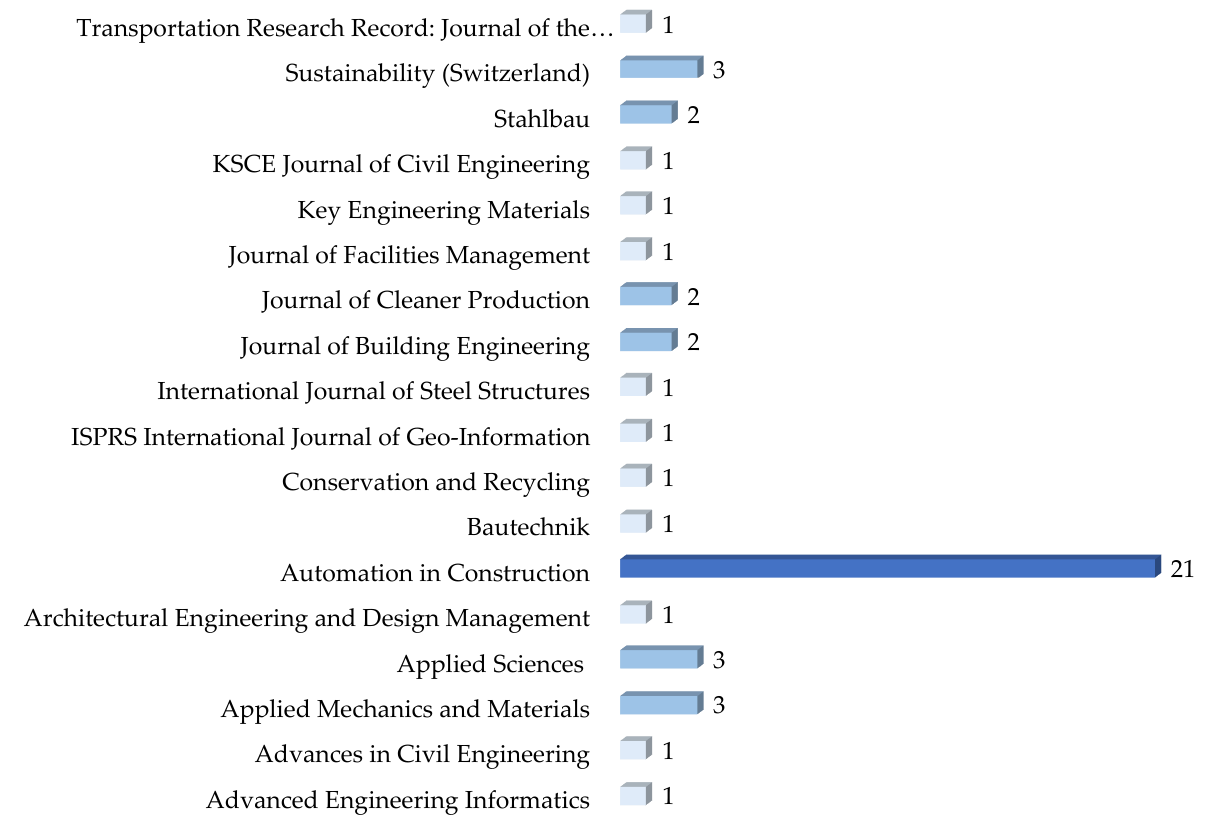
Figure 3. Evolution of the research literature review .